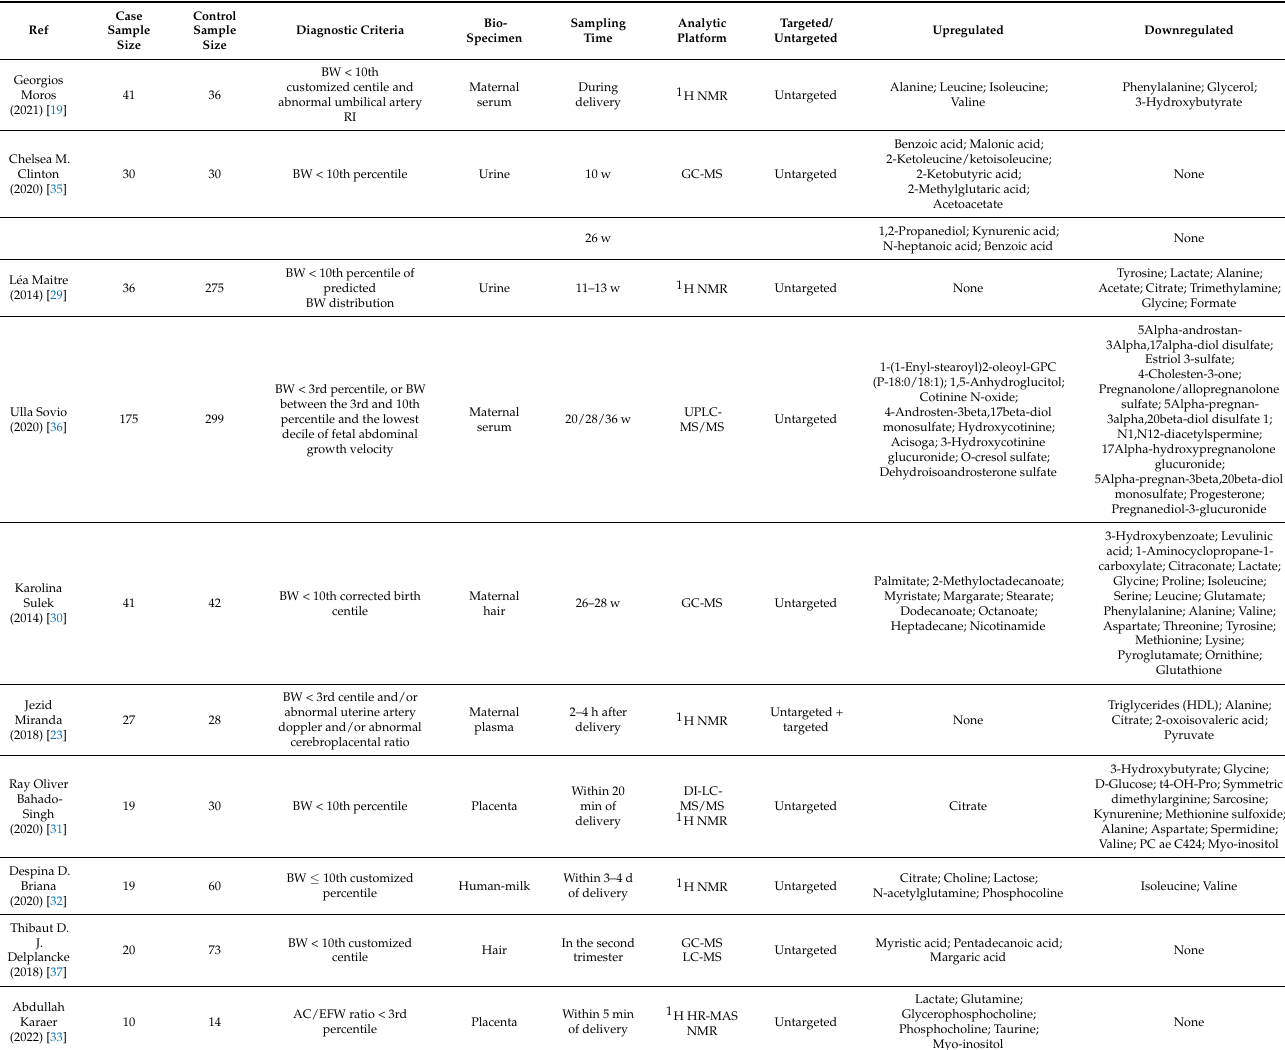
Table 3. Characteristics of the Human Maternal